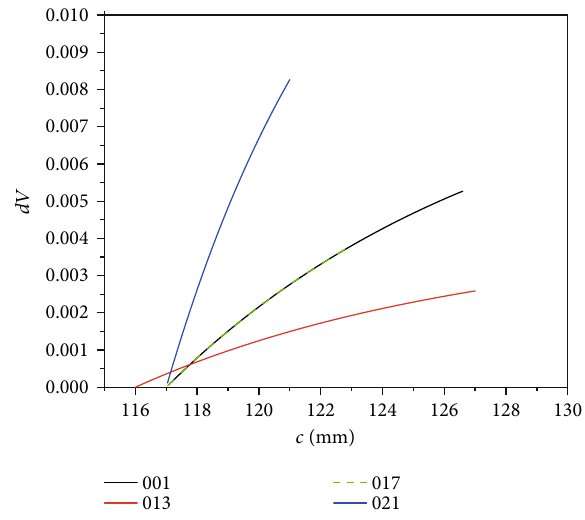
Figure 17: Wear integral curve of di ff erent fi nger locks.